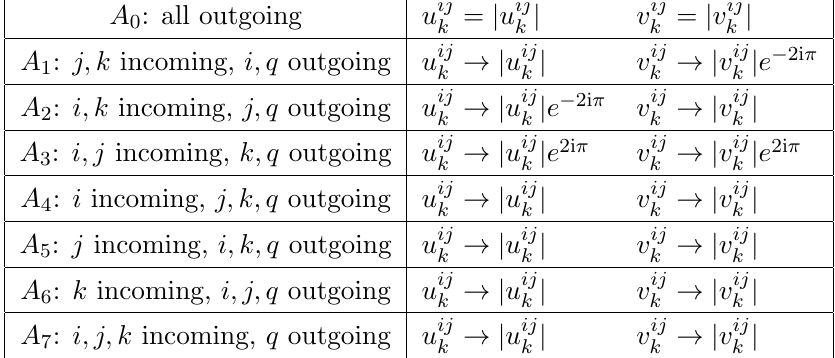
and v ij from region A 0 , also dubbed the \Euclidean" k k